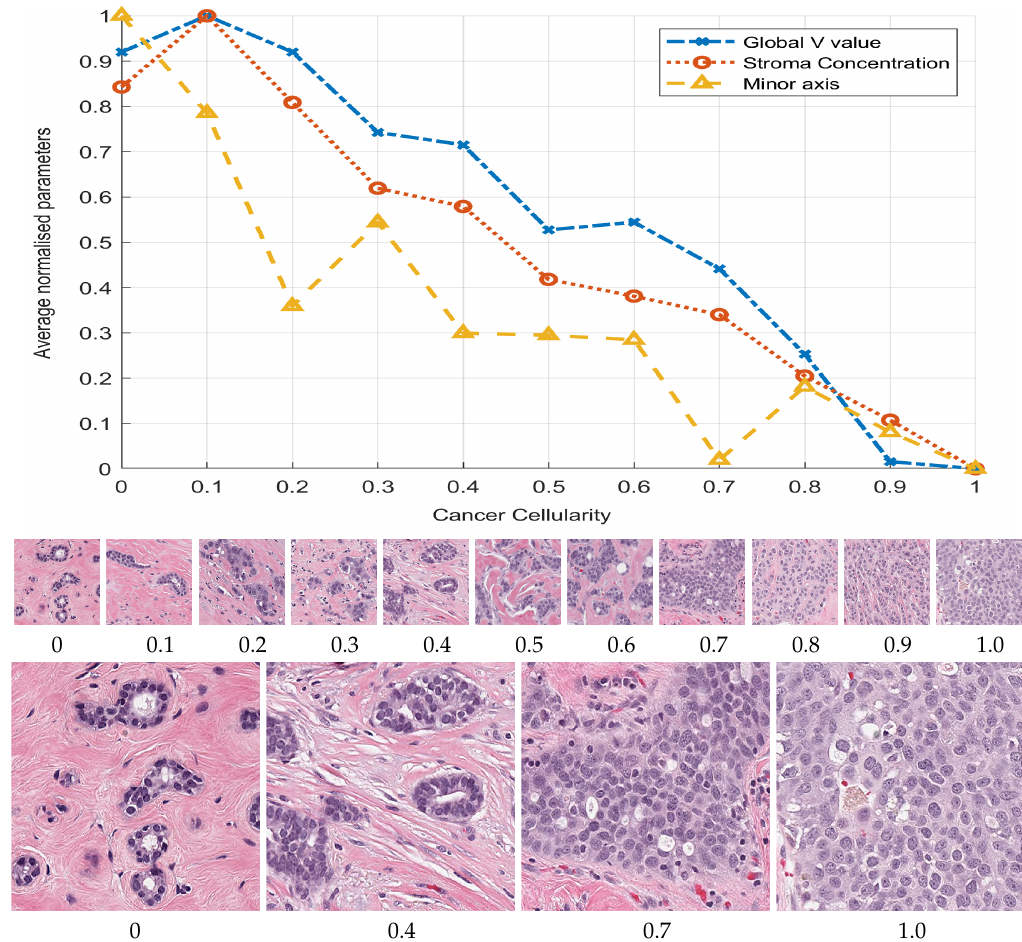
Figure 2. Graphical display of three selected morphological parameters against the cellularity: Global stroma filtered region (o), minor axis ( (cid:52) ) and Value concentration in region (x). Cellularity was manually ranked by a pathologist and the parameters automatically extracted. The plots represent average parameter value normalised with maximum value to be compared in the same graph. The graph indicates an inverse relationship between respective parameter and cellularity. Thumbnails show images with cellularity values from zero to one and magnified versions of cases with values 0, 0.4, 0.7, and 1, where the prevalence of cancerous cells can be clearly